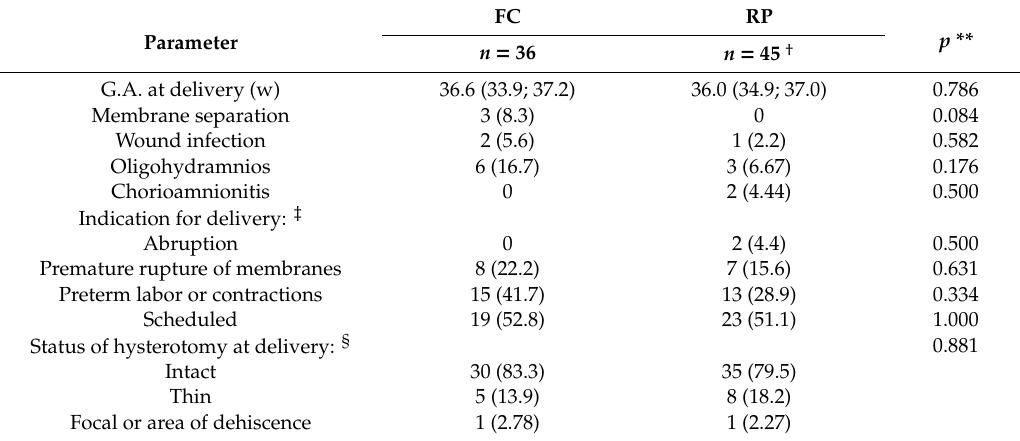
Table 2. Maternal delivery outcomes. *